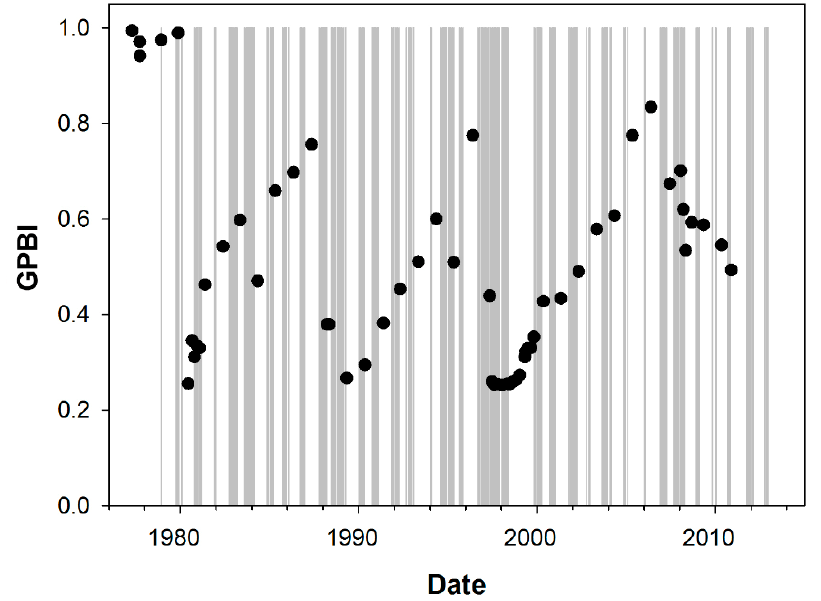
Figure 5. Case Study 4—hypoxia (Sweden, Gullmarfjord). Temporal changes in GPBI. The sampling dates used as references are indicated by a white square. Shaded areas are indicative of hypoxia events ([O 2 ] < 2 mL L − 1 ).